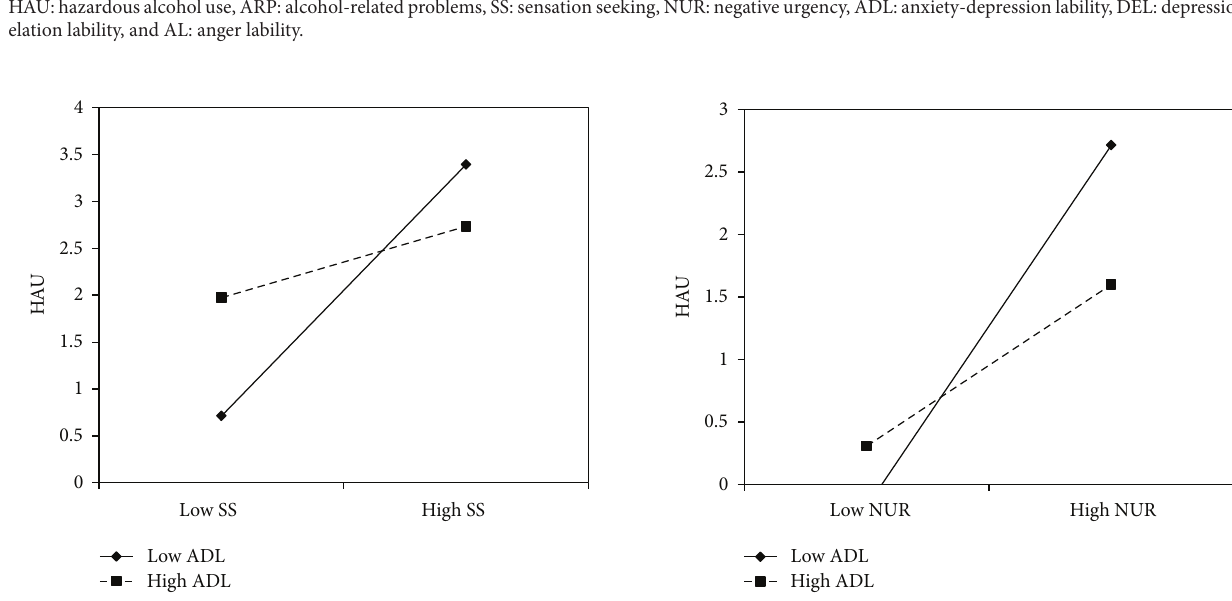
F 2: Anxiety and depression lability moderated the effect of negative urgency on hazardous alcohol use among college